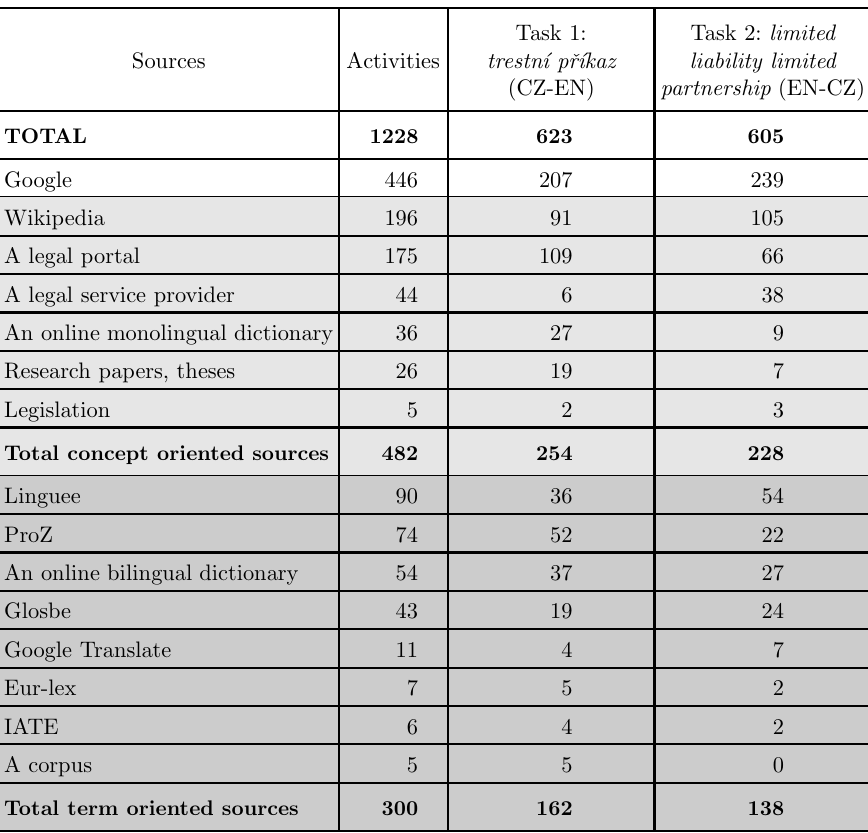
in the two tasks Task